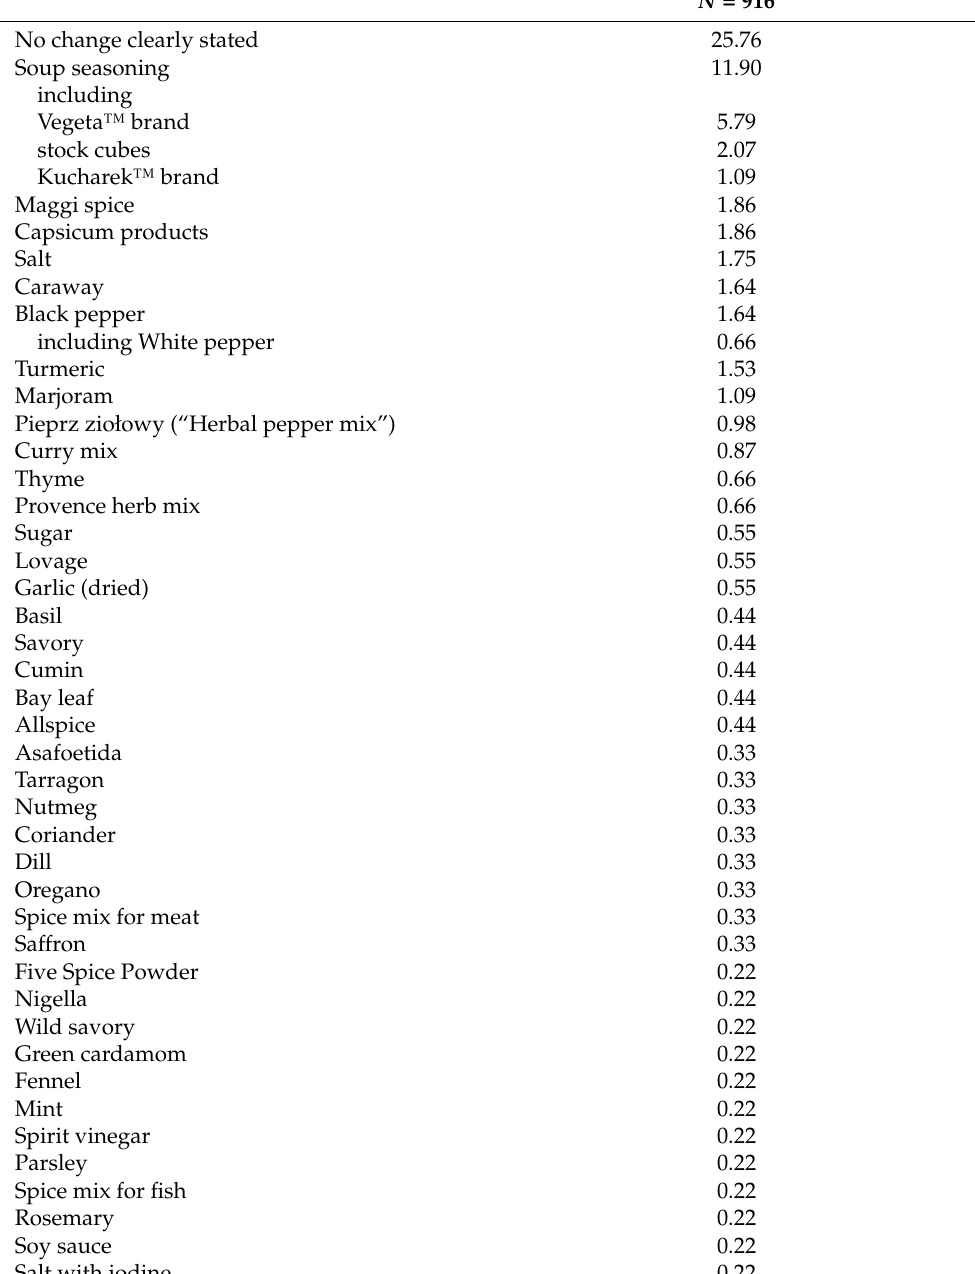
Table 4. Species and types of seasoning which respondents used 10 years ago and do not use